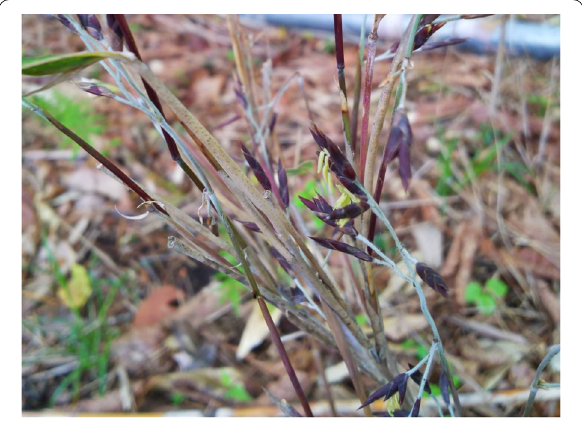
Fig. 1 Spikelets of Sasa